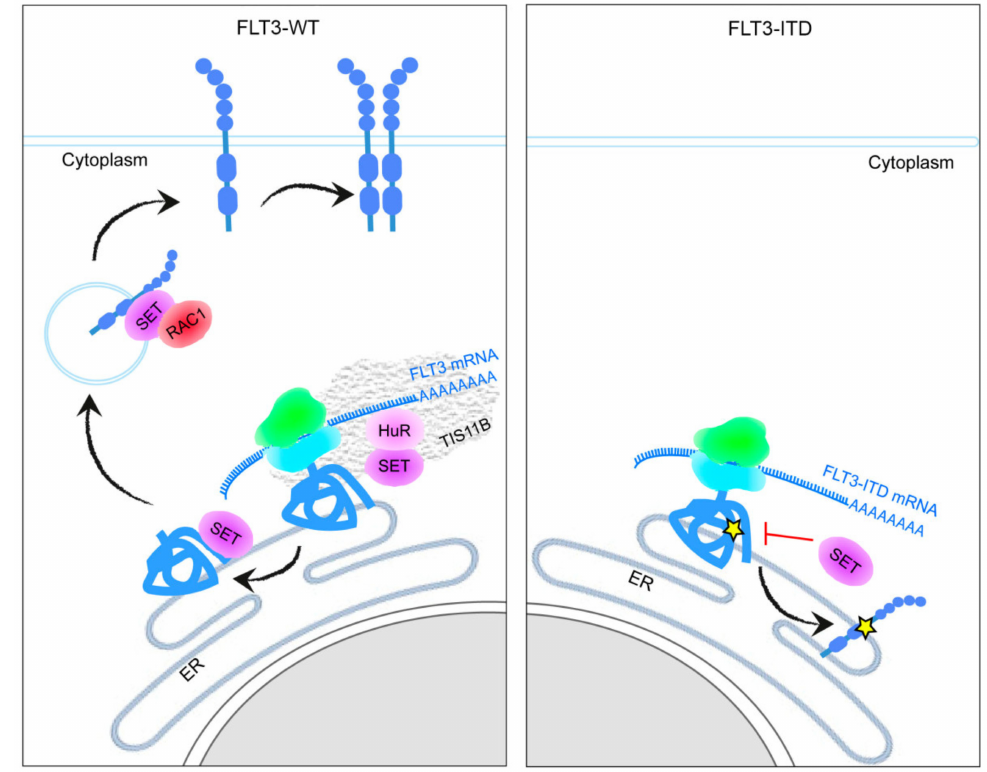
Figure 6. Schematic representation of FLT3-WT transport to the plasma membrane. FLT3-WT mRNA is transcribed in a membraneless organelle made from the mRNA-binding protein TIS11B, which forms a reticular meshwork intertwined with the ER that creates a subcellular compartment with a biophysically and biochemically distinct environment from the cytoplasm. There, the mRNA binding protein HuR binds to the 3 (cid:48) UTR of the FLT3 mRNA and recruits SET. Then, SET binds to the nascent FLT3 protein, which helps translocate FLT3 to the plasma membrane via active RAC1. When FLT3 carries the FLT3-ITD mutation, SET is not able to bind to the nascent protein, contributing to endoplasmic reticulum (ER)